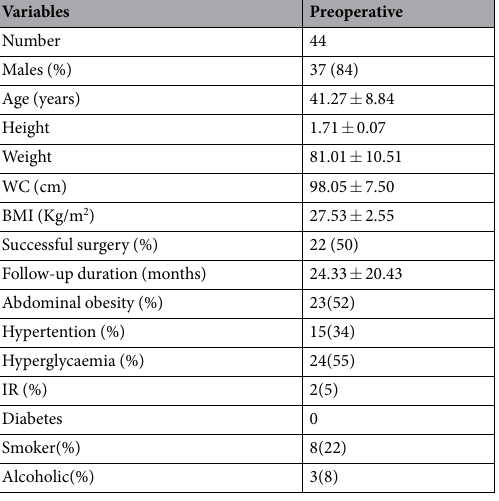
Table 1. Baseline characteristics of patients undergoing surgery to treat OSA. Abbreviations: WC = waist circumference, BMI = body mass index, IR = insulin